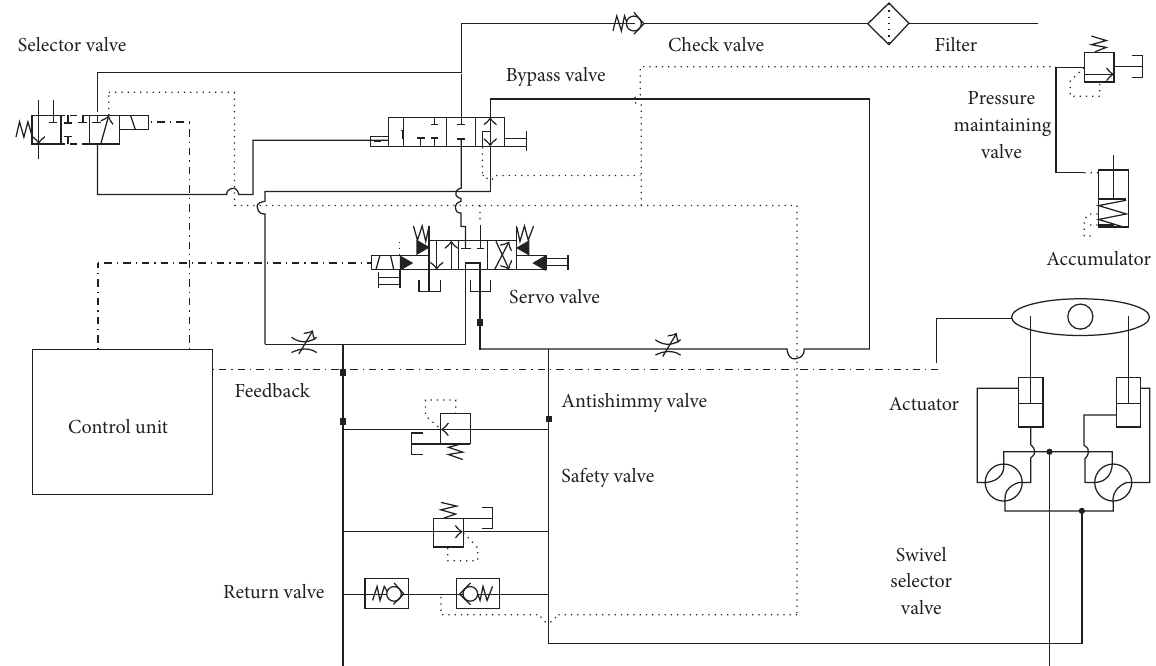
Figure 11: Design of the electrohydraulic